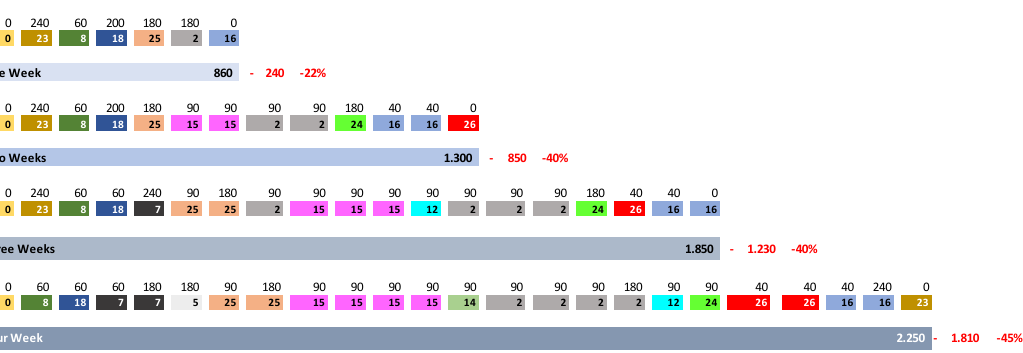
Figure 4. Optimized result for Machine 7, from the loop dye group, 13 SKUs. Figure 5 presented by the LINGO software [28], shows the fill-in of the matrix model composed of values in zeros and ones, varying only in the number of variables and constraints.